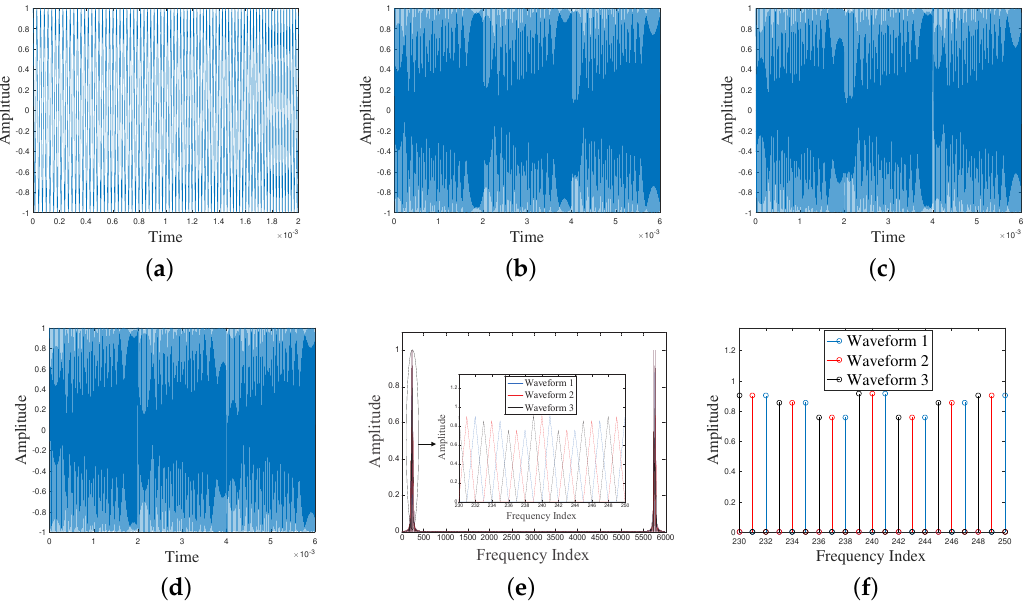
Figure 2. ( a ) 35–45 kHz/2 ms chirp in time domain with sampling frequency 1 MHz; ( b – d ) three orthogonal chirp waveforms respectively, generated from ( a ); ( e ) corresponding frequency spectra of the three orthogonal chirp waveforms shown in ( b – d ); and ( f ) stem graph of the zoom plot of ( e ).